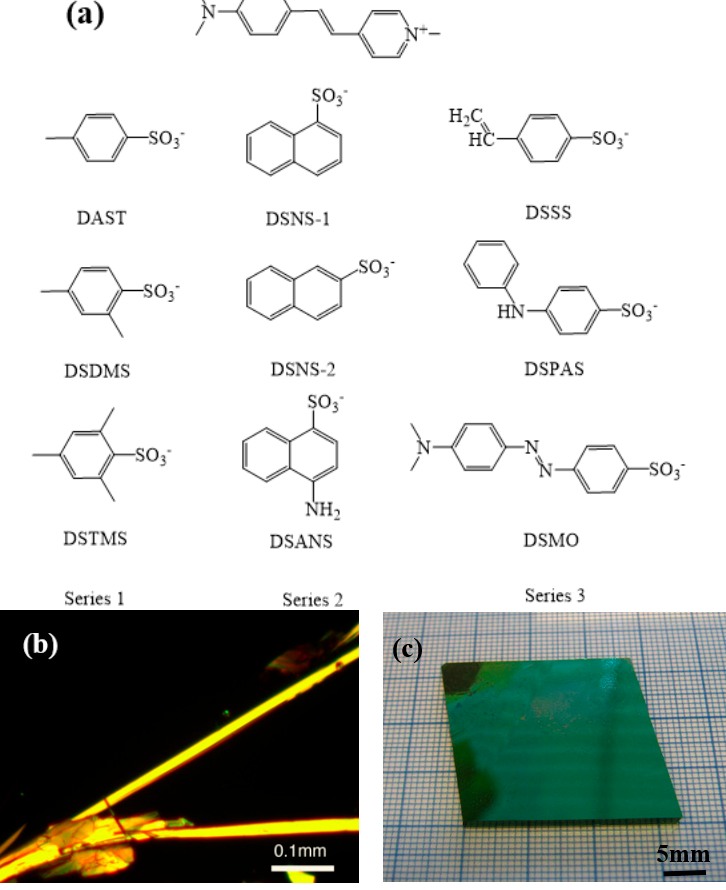
Figure 3. Molecule structures of the stilbazolium derivatives ( a ) and single crystals of 4- N , N - dimethylamino-4 ′ - N ′ -methyl-stilbazolium 2-naphthalenesulfonate (DSNS) ( b ) and 4- N , N -dimethylamino- 4 ′ - N ′ -methyl-stilbazolium 2,4,6-trimethylbenzenesulfonate (DSTMS) ( c ).